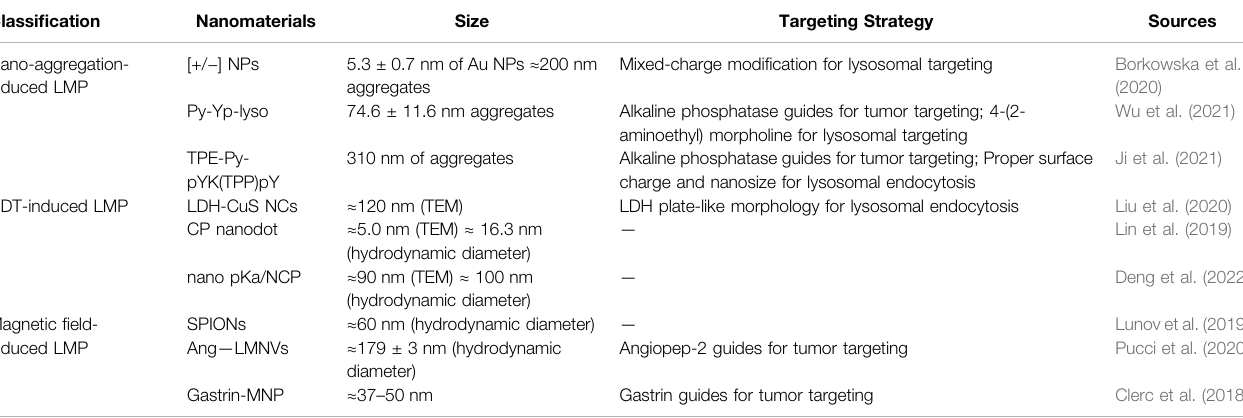
TABLE 1 | Nanodrugs detonate